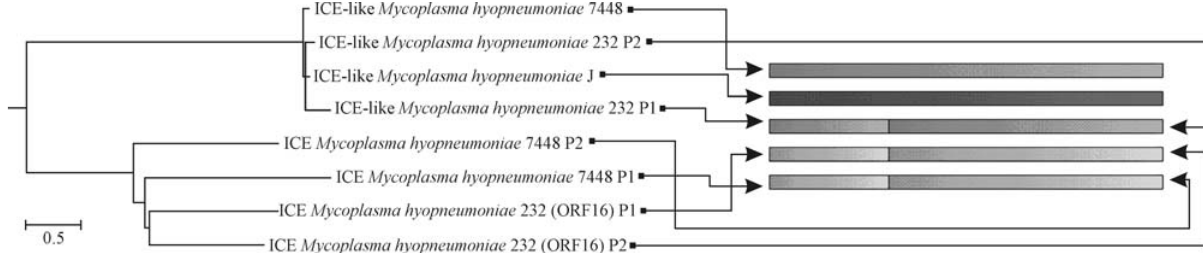
Figure 5 - Recombination tree based on the traE sequences on the left is based on the representation of the traE mosaic